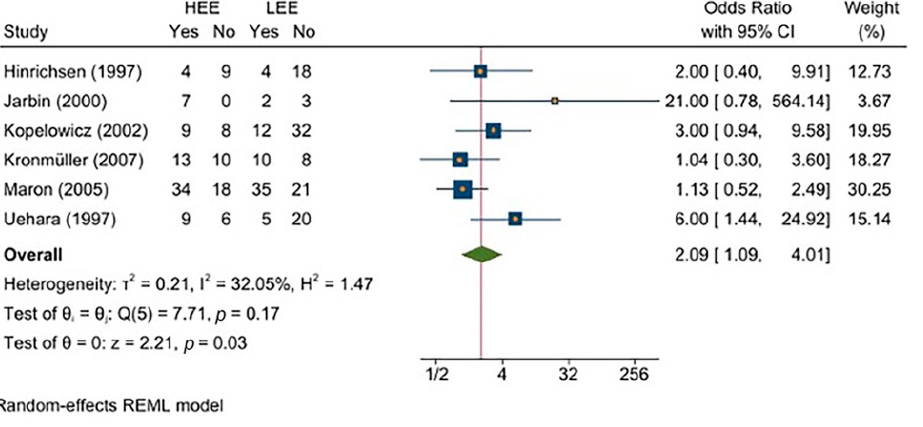
Figure 2. Forest plot of the meta ‐ analysis with all six studies included [35,37–41].